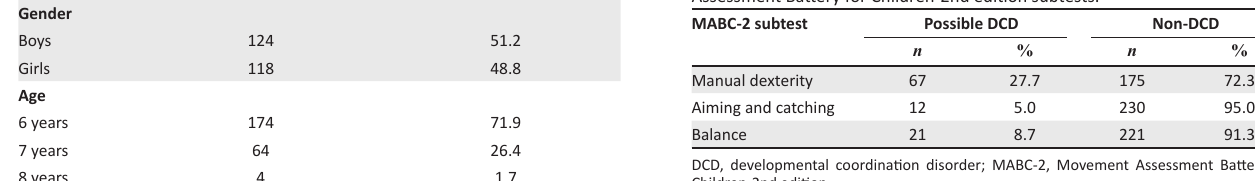
TABLE 2: Characterisation of participants ( N = 242) in terms of gender and age. Variable